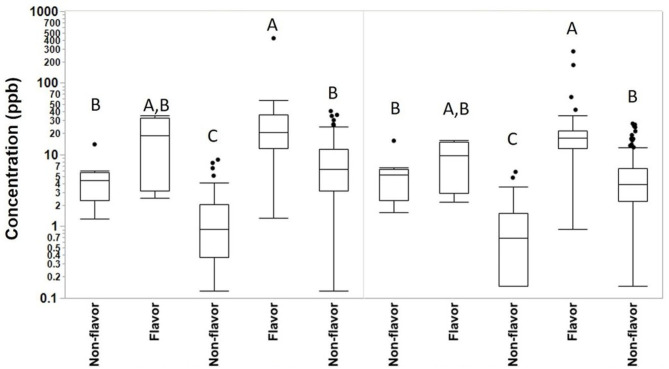
Full-shift TWA personal exposures to diacetyl and 2,3-pentanedione among café, production and non-production workers in flavoring and non-flavoring facilities in samples analyzed using modified OSHA Method 1013/1016. From left to right, number of samples n = 18 for café, n = 6 for non-production flavoring, n = 41 for non-production non-flavoring, n = 91 for production flavoring, and n = 259 for production non-flavoring. By compound, connecting letters indicate groups not statistically different.